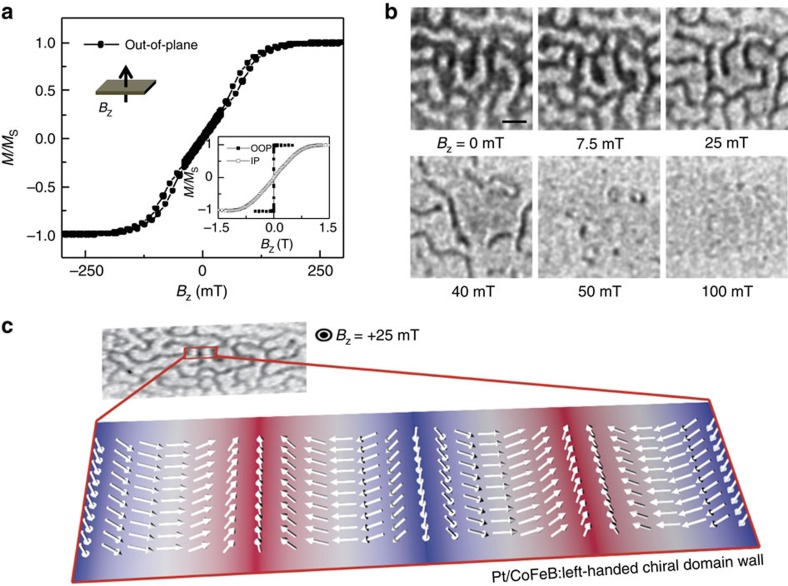
Structural characteristics and X-ray imaging of domain patterns.(a) Out-of-plane hysteresis loop for a companion multilayer film grown on Si wafer. The magnetic moment is normalized to its saturation magnetization MS=9 × 105 A m−1. The inset shows both in-plane and out-of-plane hysteresis loops for a Pt/CoFeB/MgO unit layer grown on Si wafer. (b) Series of magnetic transmission soft X-ray microscopy (MTXM) images acquired for increasing field Bz>0. Dark and light contrast corresponds to down (−z)- and up (+z)-oriented magnetization directions, respectively. Scale bar, 200 nm. (c) MTXM image acquired at Bz=+25 mT and the schematic of the expected chiral magnetic textures.